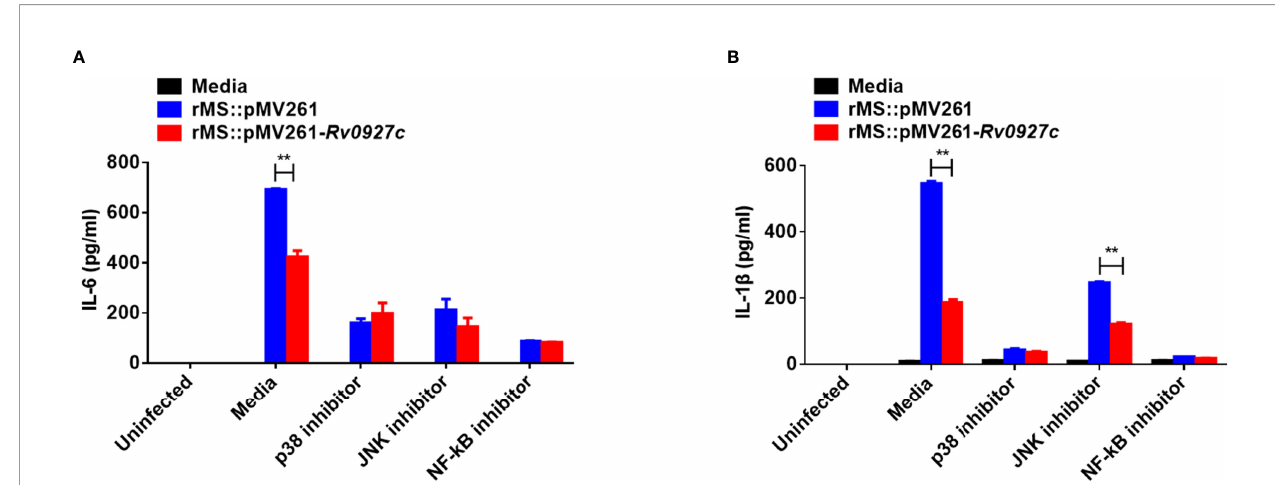
FIGURE 5 | Inhibition of proin fl ammatory cytokines by Rv0927c requires the NF- k B and p38 pathways. RAW264.7 cells were pretreated with the p38, Jnk, or NF- k B inhibitor for 1 h and then infected rMS::pMV261 and rMS::pMV261- Rv0927c for 24 h (MOI = 10). Production of IL-6 (A) and IL-1 b (B) in the culture supernatants was determined by ELISA. ** P < 0.01 (unpaired two-tailed Student ’ s t test). Data are representative of one experiment with two independent biological replicates (mean and sem of n = 3